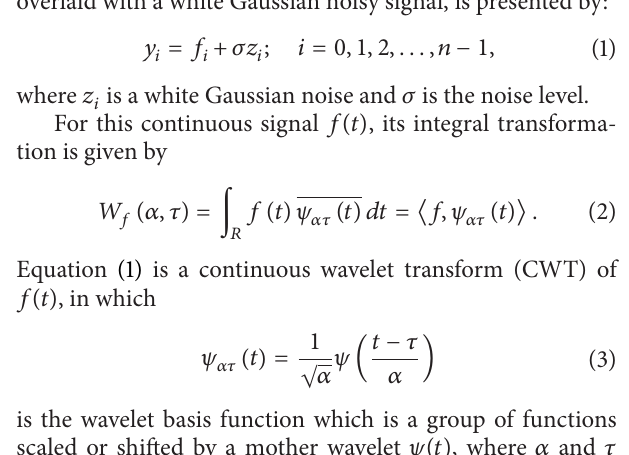
Table 1: The calibrated tripping speed